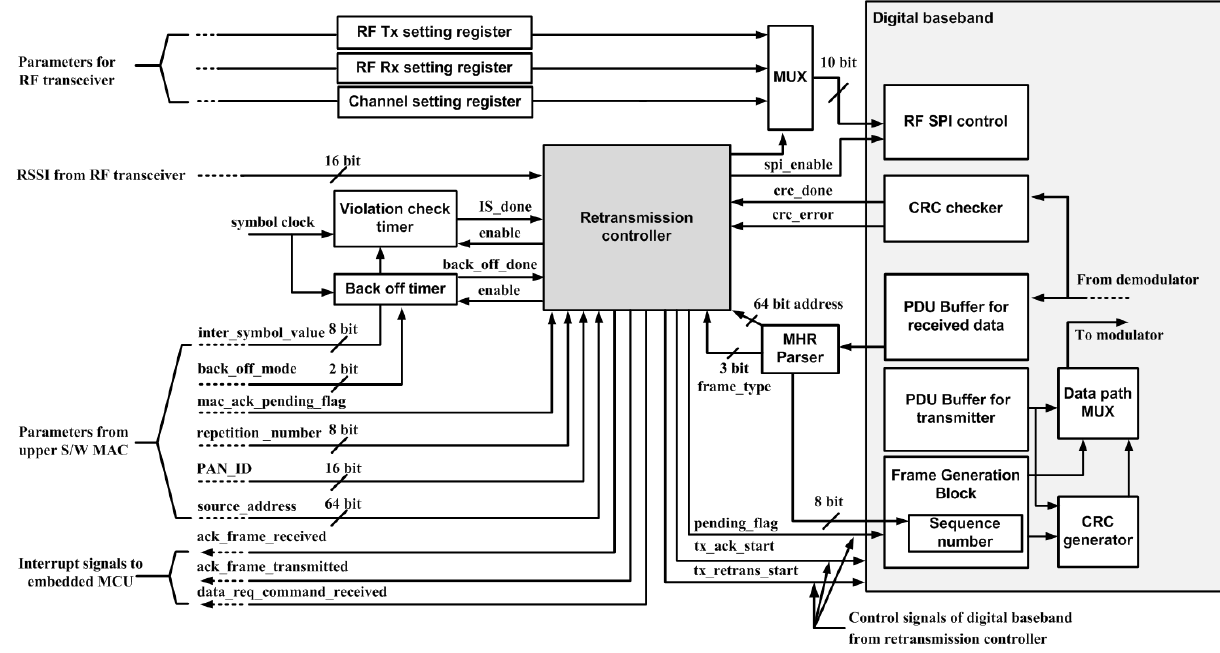
Figure 7. Block diagram of digital MAC function